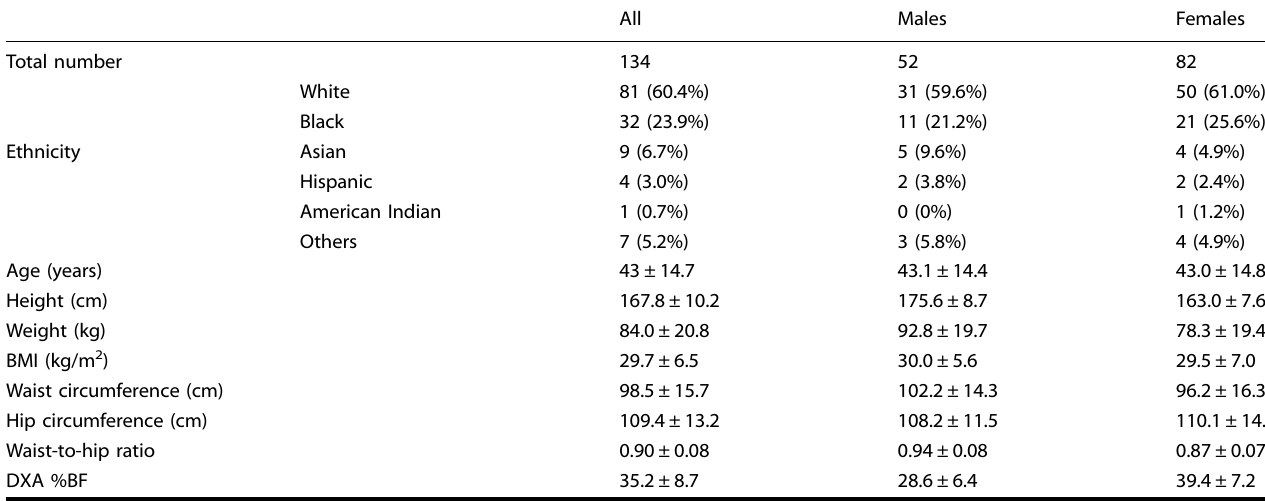
Table 1. Subject